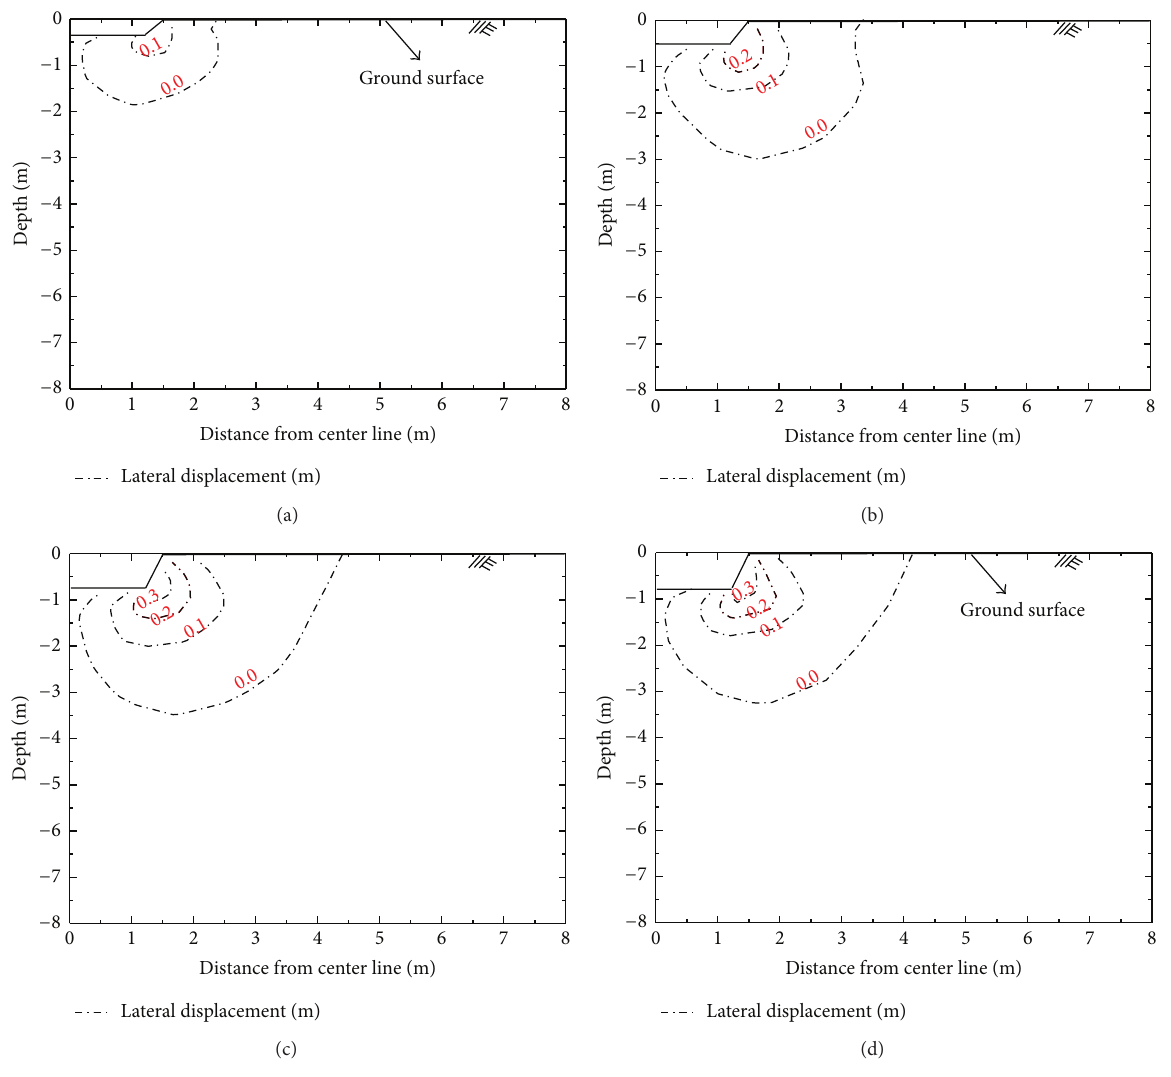
Figure 9: Contour lines of lateral displacement for the first blow: (a) 0.05 s, (b) 0.1s, (c) 0.2 s, and (d) 0.3 s.